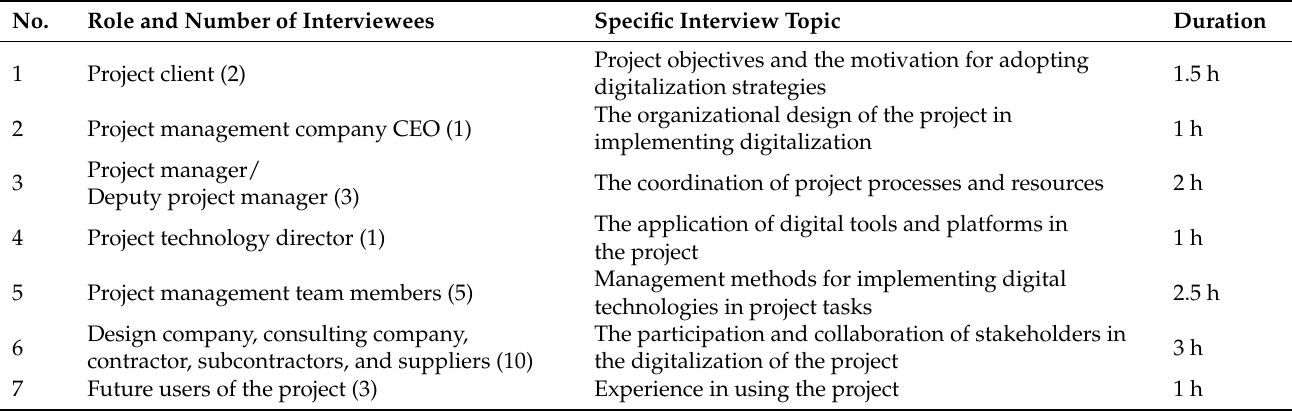
Table 1. Key information of focus group